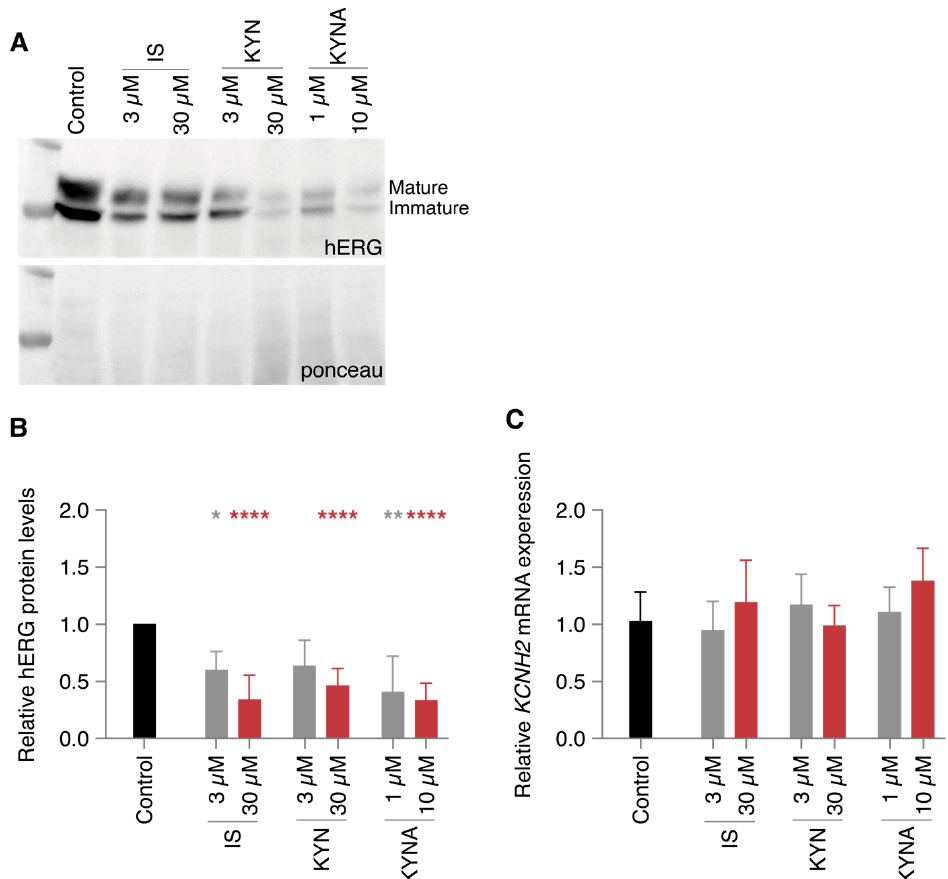
Figure 3. Diminished hERG protein levels caused by chronic uremic toxin exposure. HEK cells stably expressing the hERG ion channel were exposed to two concentrations of indoxyl sulfate (IS), kynurenine (KYN), and kynurenic acid (KYNA) for 48 h. ( A , B ) Example and quantification of protein levels. ( C ) Quantification of KCNH2 mRNA levels. Data are shown as the mean ± SD. Numbers of biological repeats = 3–5 ( B ) and 5 ( C ). * p < 0.05, ** p < 0.01, **** p < 0.0001 compared to control.